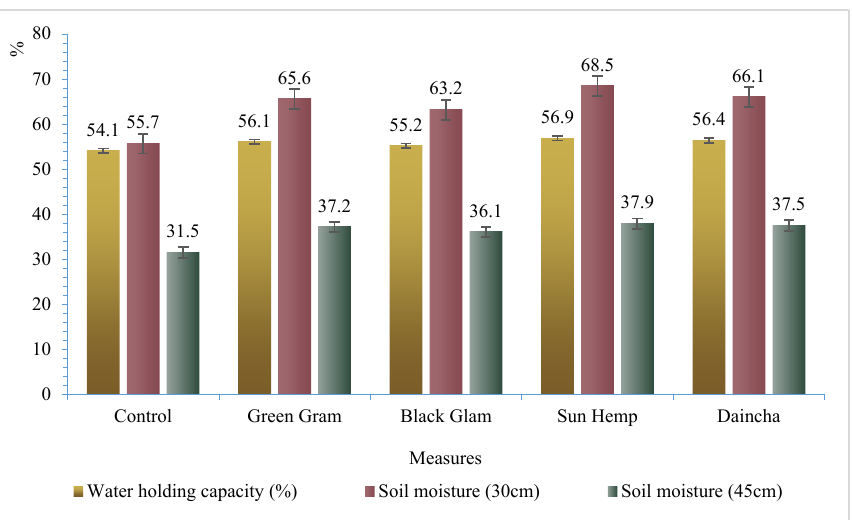
Figure 4. Water-holding capacity and soil moisture content under various agronomic